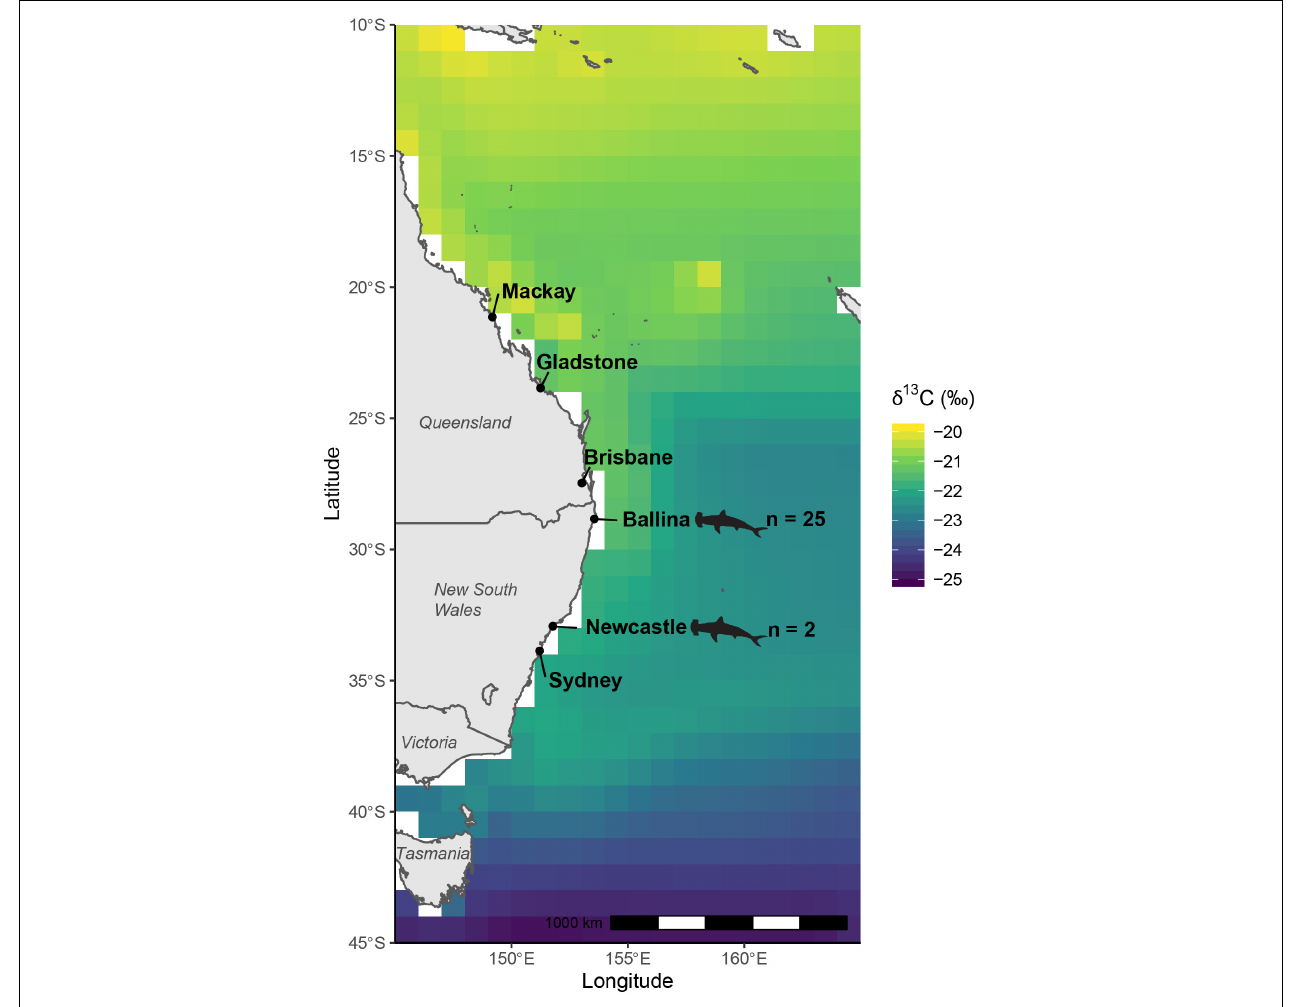
FIGURE 1 | Modeled, biomass-weighted annual median δ 13 C values of oceanic phytoplankton off eastern Australia per degree of latitude extracted from NEMO-MEDUSA framework, which predicts stable isotope values from modeled sea surface temperature, dissolved inorganic carbon content and isotopic composition and phytoplankton biomass and growth rates. Locations where great hammerhead shark ( Sphyrna mokarran ) samples were collected are indicated by shark outlines.